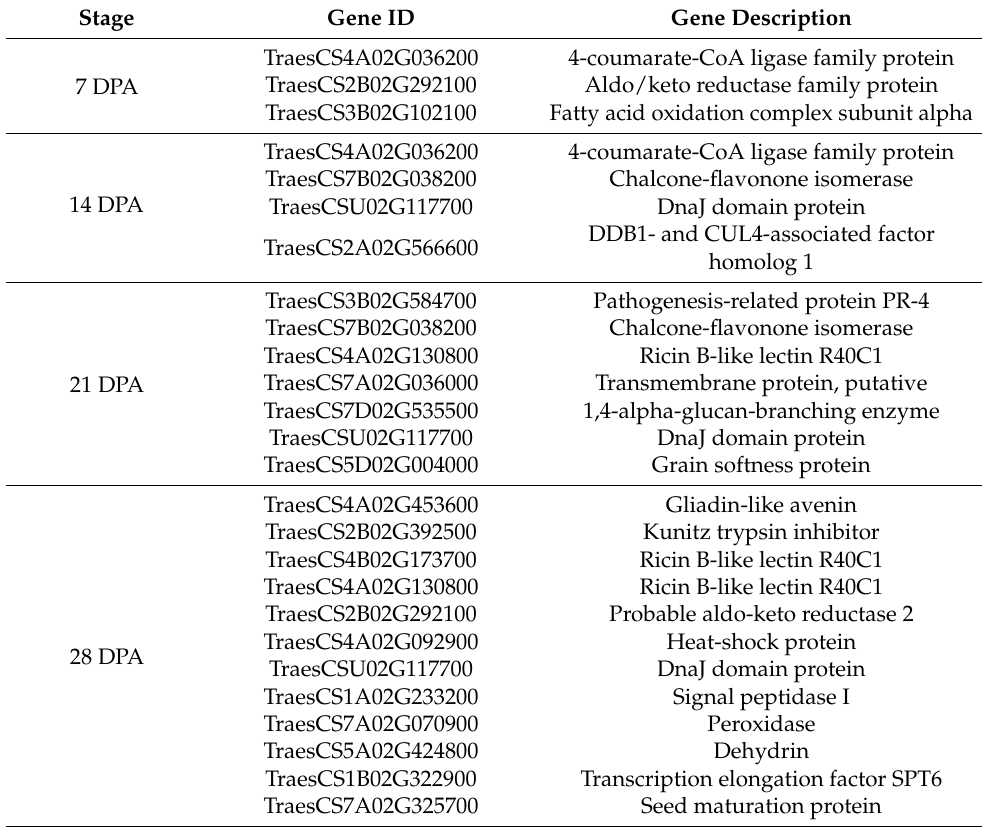
Table 2. Commonly identified genes from both transcriptome and proteome at different stages. Stage